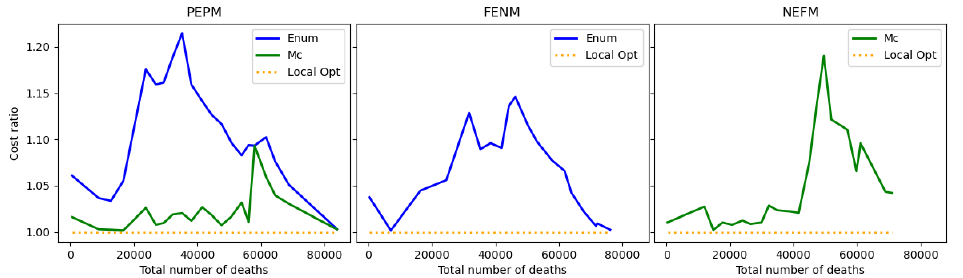
Figure 6. Ratio of costs achieved following different optimization stages compared to the final cost obtained following local optimization. Costs are given as a function of the number of deaths in the Pareto-optimal calculated solution.